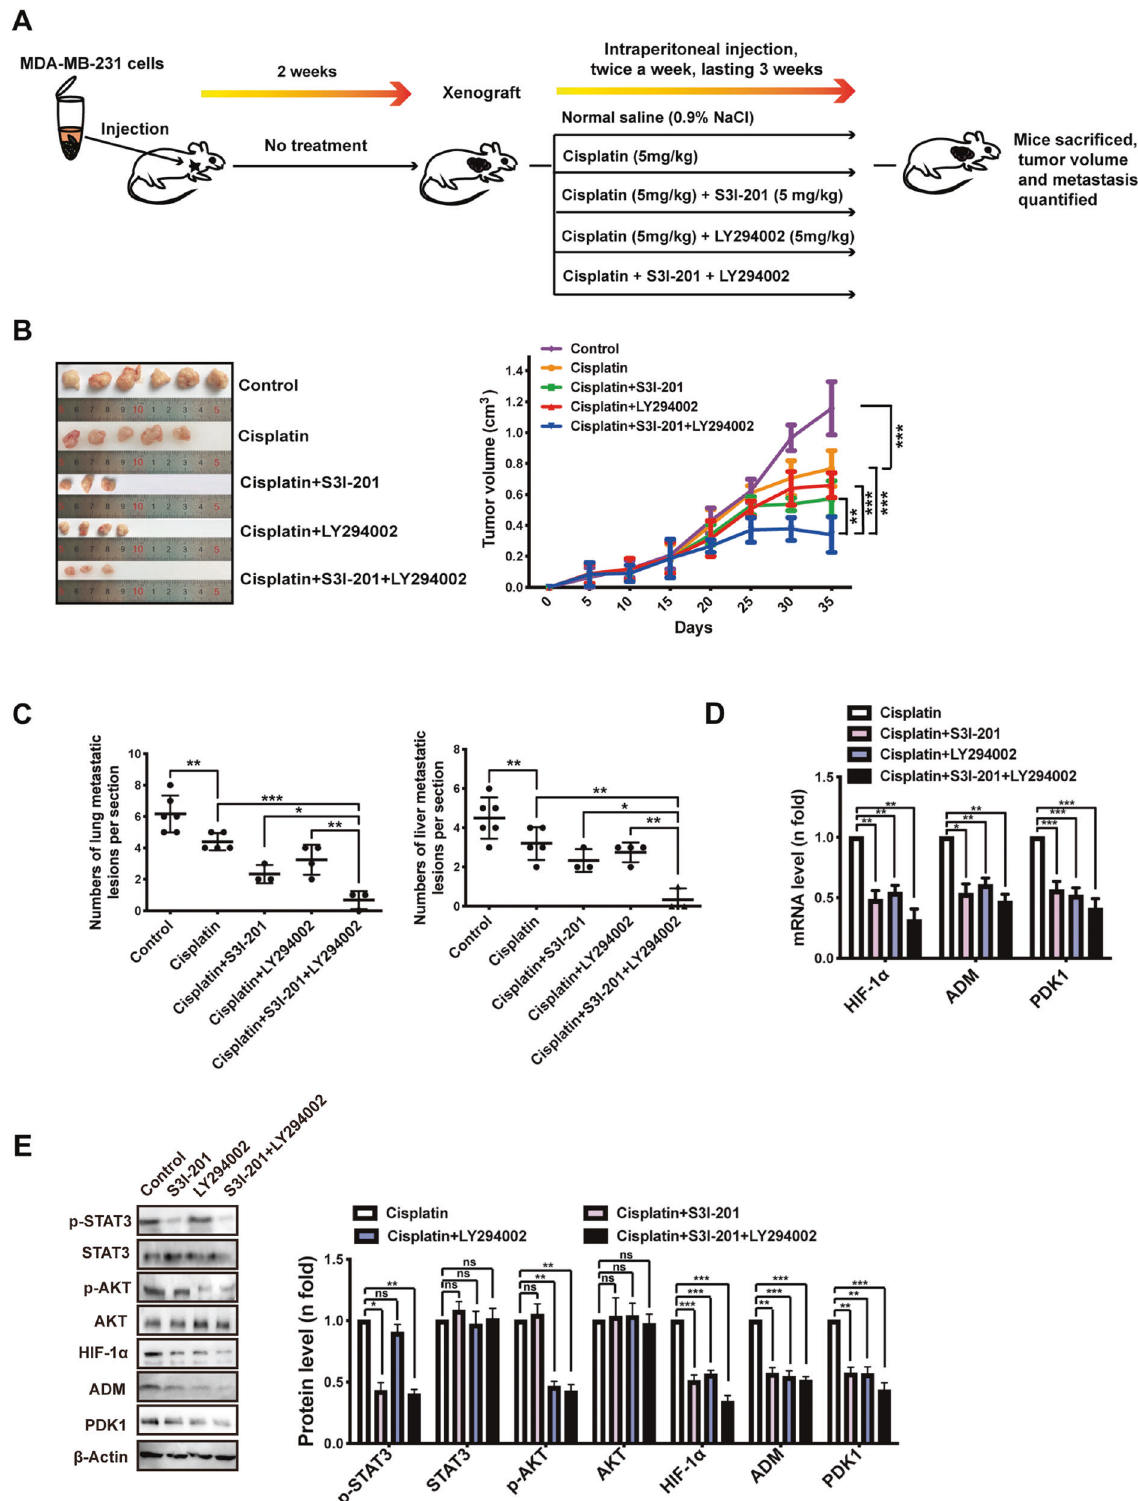
Fig. 6 In vivo signi fi cance of co-targeting STAT3 and AKT to suppress HIF-1 α signaling and to increase drug sensitivity. A A proposed model of xenograft experiment. In brief, six million MDA-MB-231 cells were implanted subcutaneously into the fl anks of Balb/c nude mice. Dosing of the indicated drugs was initiated when tumor sizes reached 200 mm 3 after 2 weeks. B Primary tumor size was measured (left) and quanti fi ed (right). C Primary tumor and representative metastasis specimens (yellow arrow heads) were HE stained (left). The numbers of metastatic lesions in lung and liver were quanti fi ed (right). D Expressions of HIF-1 α and its target genes from inoculated tumor tissue were detected via qRT-PCR. E Western blotting illustrated the inhibition of STAT3 or PI3K/AKT signaling by its corresponding inhibitor as well as the downregulations of HIF-1 α and its target genes. Error bars represent means ± SD from triplicates. Data are representative of at least three independent experiments. * p < 0.05, ** p < 0.01, *** p < 0.001; ns, not signi fi cant. Cell Death and Disease (2022)